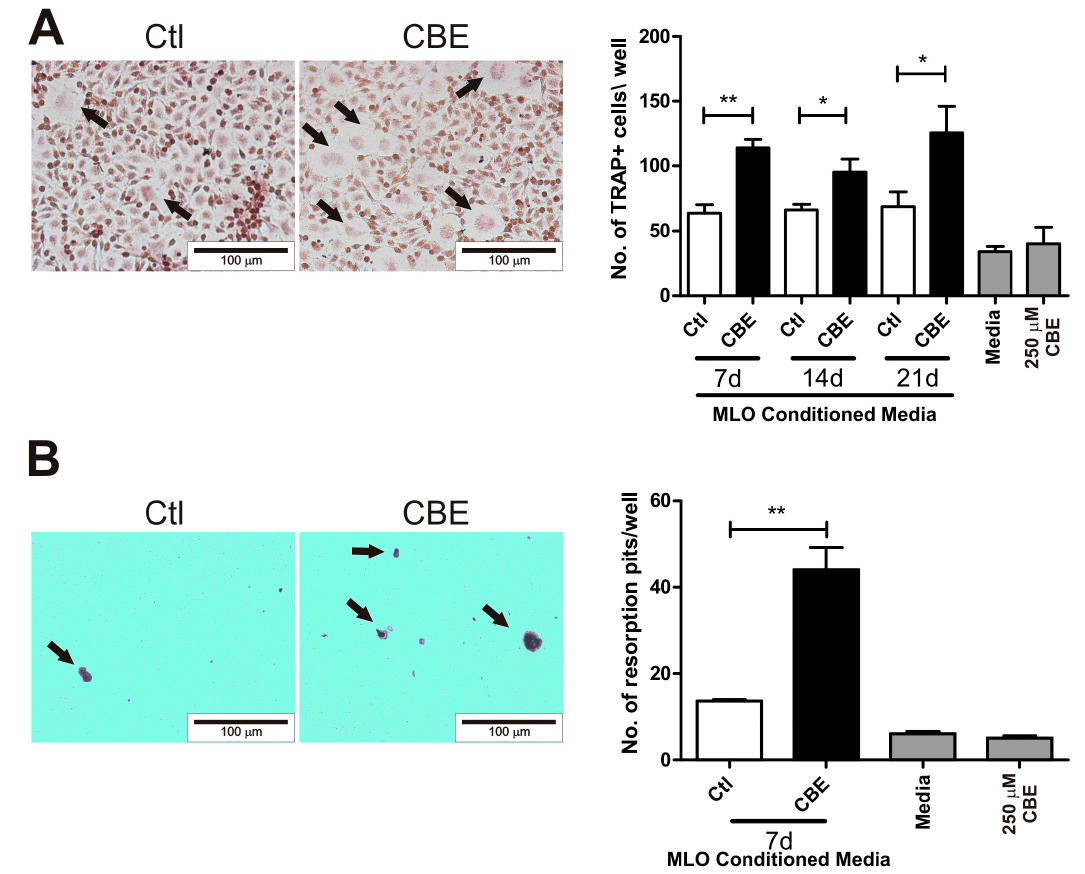
Figure 1. Induction of osteoclast differentiation by osteocyte conditioned media. MLO-Y4 cells were treated with conduritol- β -epoxide (CBE) for seven, 14 and 21 days (d), and conditioned media were harvested. Osteoclast precursors were exposed to conditioned media, and osteoclast generation was analyzed. Tartrate resistant acid phosphatase (TRAP) positive cells with ≥ 3 nuclei were counted ( A ); and the number of resorption lacunae were evaluated in osteoclast precursors exposed to conditioned media from osteocytes treated with CBE for seven days ( B ). Black arrows indicate osteoclast-like cells ( A ) or resorption lacunae ( B ), respectively. As control conditions, osteoclast precursors were treated with complete media (Media) or 250 µ M of CBE. Data are expressed as mean ± SD ( n = 5) and are representative of three independent experiments performed. * p < 0.05, ** p < 0.01 t -test.